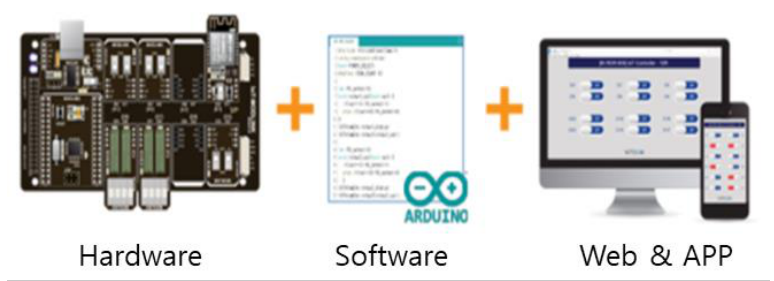
Figure 9. Composition of hardware (HW), software (SW), Web, App of IoT control module.